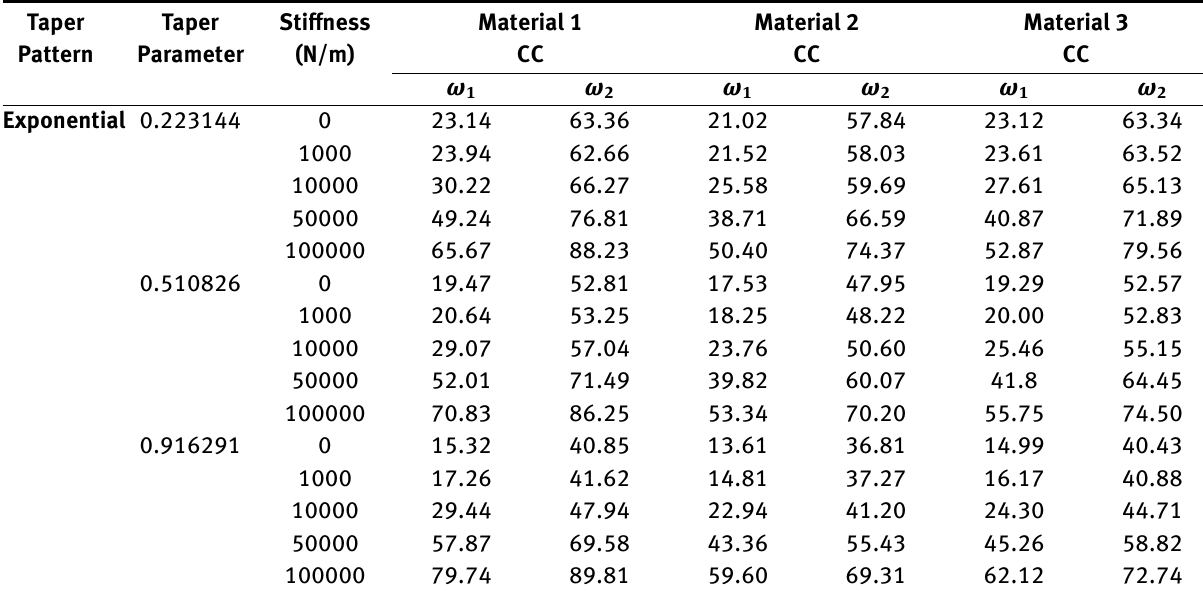
Table 5: Values of natural frequencies for 1 st and 2 nd mode ( ω 1 and ω 2 ) corresponding to exponential tapered clamped AFG beam for differ- ent combinations of taper parameter, spring stiffness and material